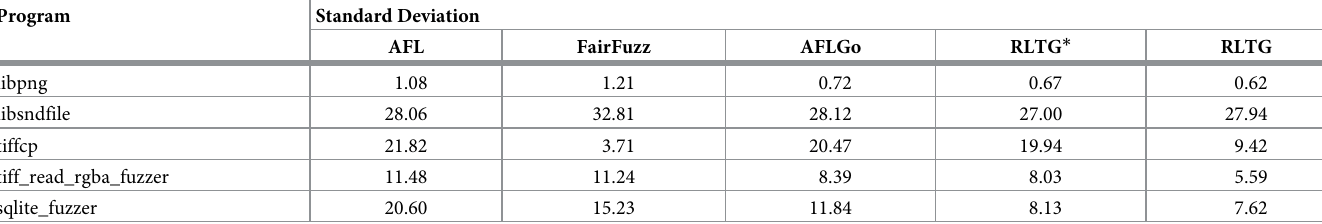
Table 2. Standard deviation of the number of testcases reaching different vulnerability sites in different programs. Program